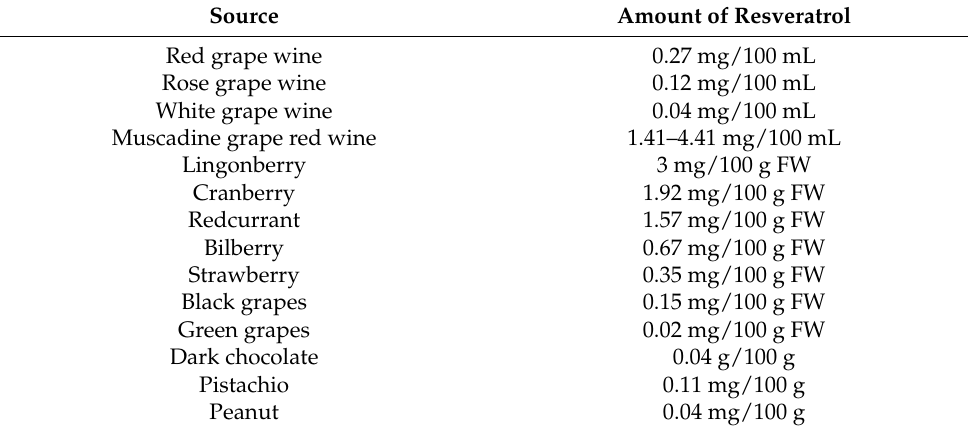
Table 1. Abundance of resveratrol in different sources. Data was obtained from Phenol-Explore database (http://phenolexplorer.eu/, accessed on 15 February